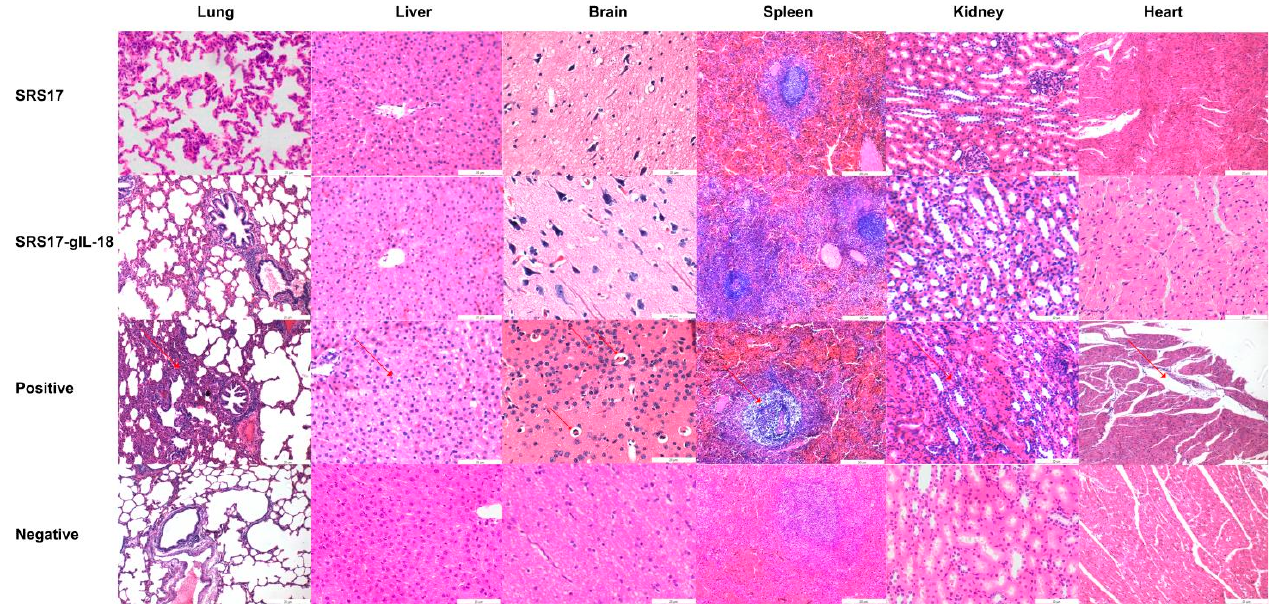
Figure 5. Immunoprotective effects of recombinant IL-18 and NcSRS17-gIL-18 proteins on goats after N. caninum infection. ( A ) Western blot analysis of the recombinant proteins gIL-18 and NcSRS17-gIL-18 with an anti-His monoclonal antibody. Lane 1: bacteria transformed with the pET-32a vector; lane 2: recombinant gIL-18; lane 3: recombinant NcSRS17-gIL-18. ( B ) Levels of IgG in the serum of goats. ( C – E ) Levels of IL-4, IL-12 and IFN- γ in the serum of goats. ( F ) The goats have been injected with recombinant proteins NcSRS17 and NcSRS17-gIL-18 (Goat intravenously injected with 10 9 N. caninum is used the positive control and un-treated goats is used the negative control) and real-time PCR results of the brain genome in each group of goats. “ ** ” represents p < 0.01, “ *** ” represents p < 0.001, “ **** ” represents p < 0.0001.